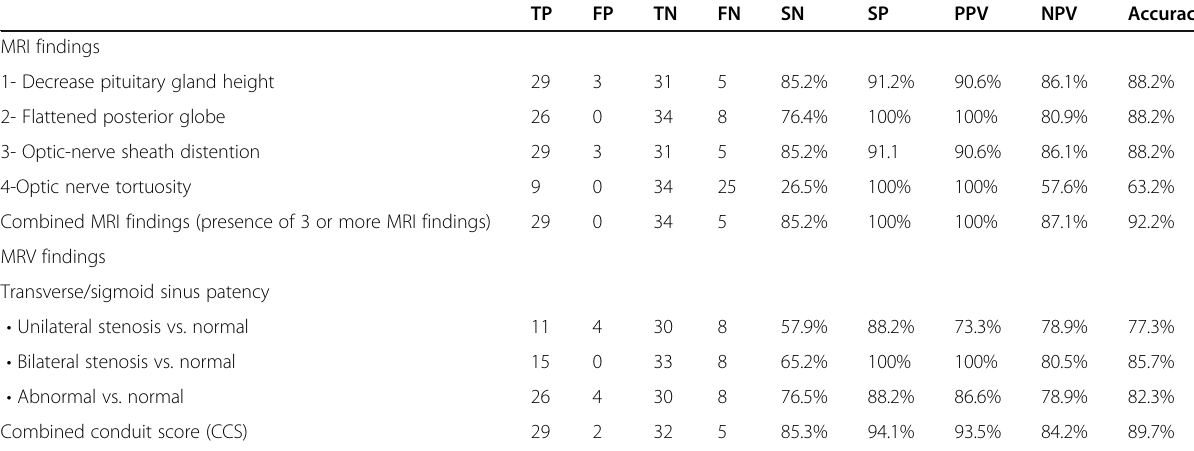
Table 4 Diagnostic performance of MRI and MRV findings in discriminating IIH cases from control